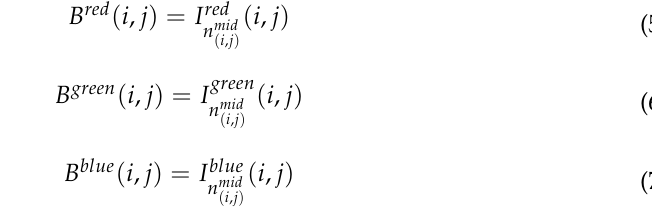
), and ( c ) blue mode ( I blue 539